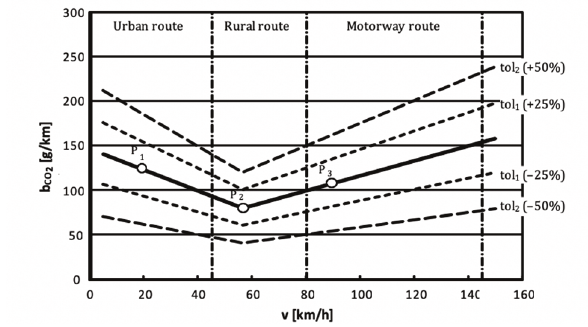
Fig. 3. Vehicle CO 2 characteristic curve